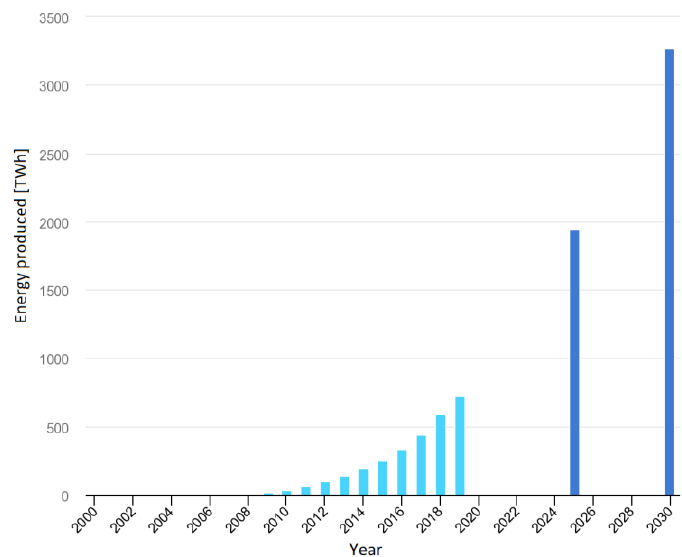
Figure 1. Solar photovoltaic generation: trend for 2000–2019 and targets for 2025 and 2030 [8] © IEA